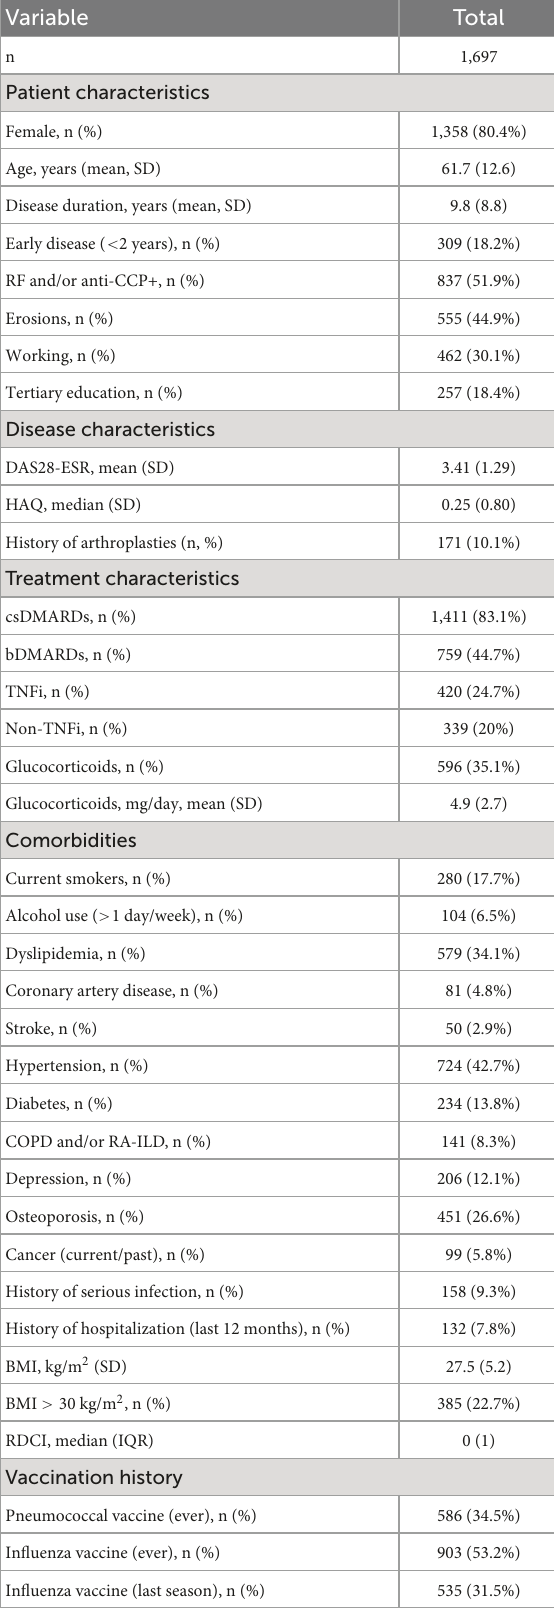
TABLE 1 Patient and disease characteristics at baseline. TABLE 2 Comparison of patients with and without a history of pneumococcal vaccination at